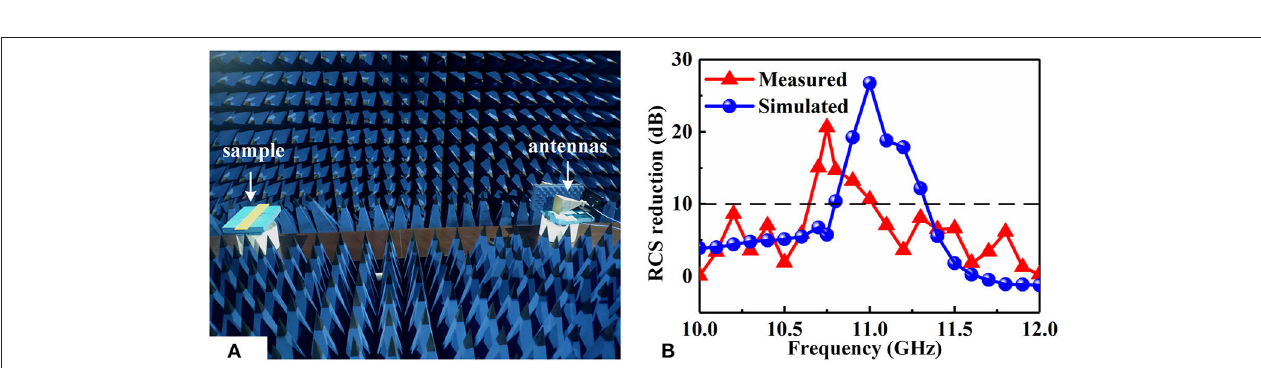
FIGURE 6 | (A) The measurement setup for RCS reduction measurement. (B) Comparison of simulated and measured RCS reduction.